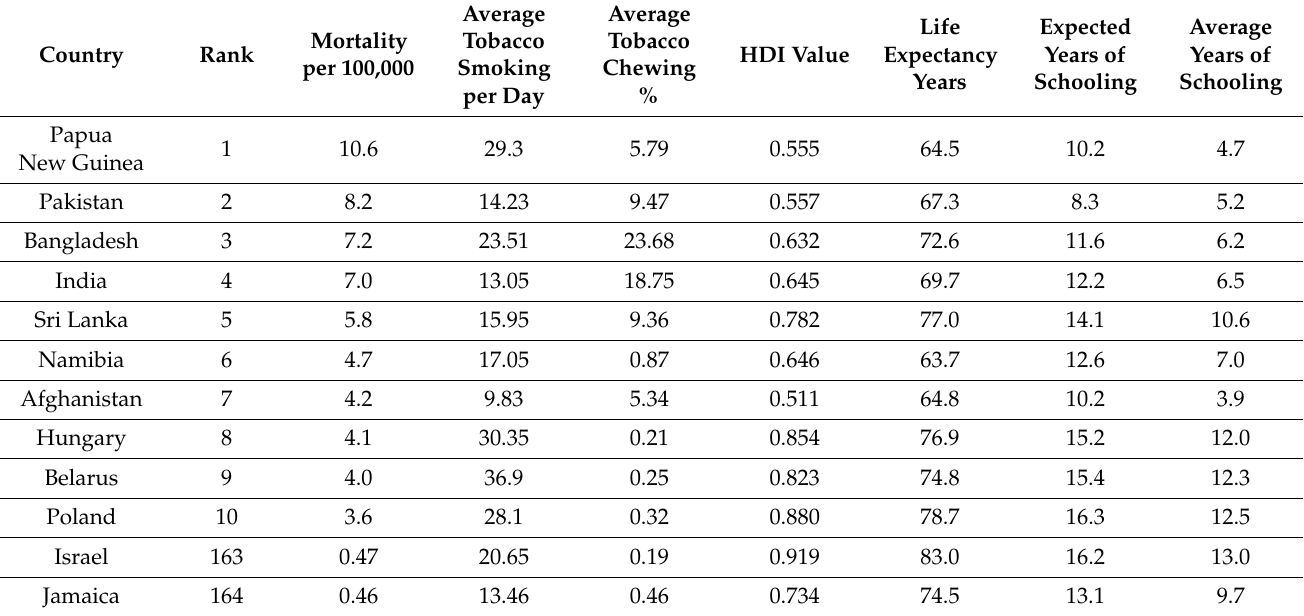
Table 2. LOCC mortality, 10 countries with the highest and 10 with the lowest incidence